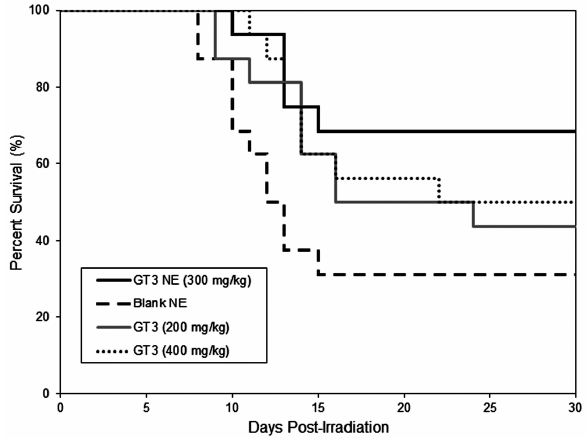
Figure 10. Kaplan–Meier survival curves for CD2F1 mice after irradiation at 9.0 Gy following oral administration of blank NE, GT3 NE (300 mg/kg), and GT3 (200 and 400 mg/kg), ( n = 16) 24 h prior to irradiation.